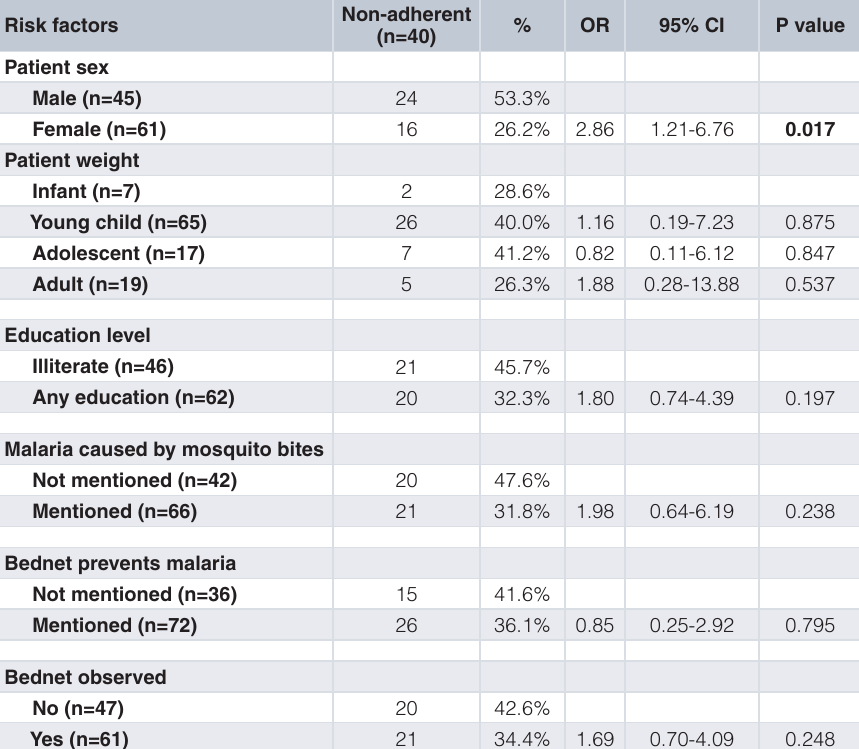
Table 11. Multivariate regresssion of potential risk factors to ACT